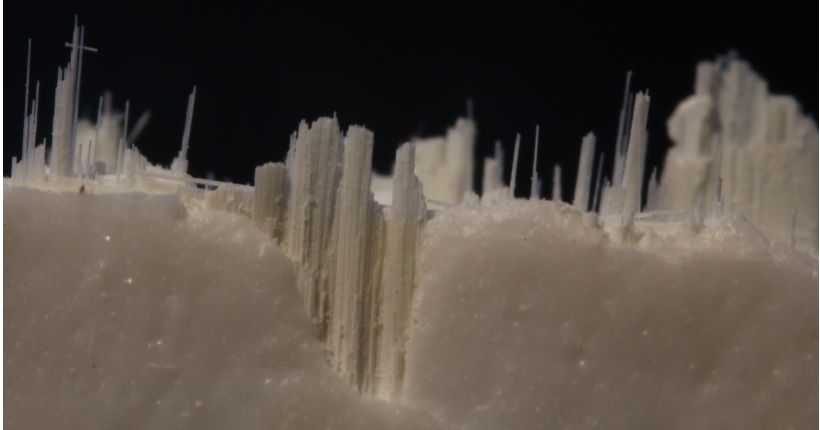
Figure 14. The coated sample of FW12 shows smooth fracture edges of the coating after a bending test, while the fibre pull-out of the base material, which is responsible for the damage tolerance, is